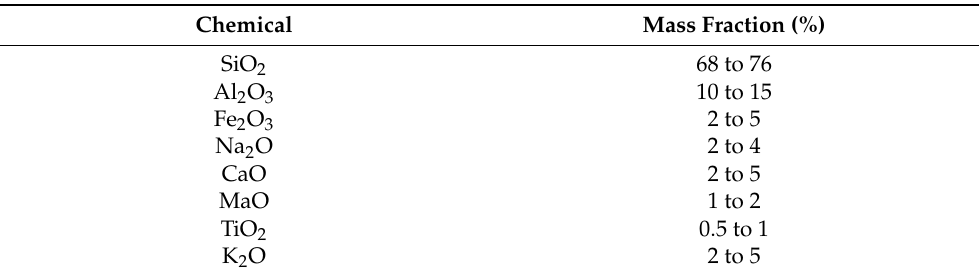
Table 1. Chemical composition of dust particles from International Standards Organization (ISO) 12103-1